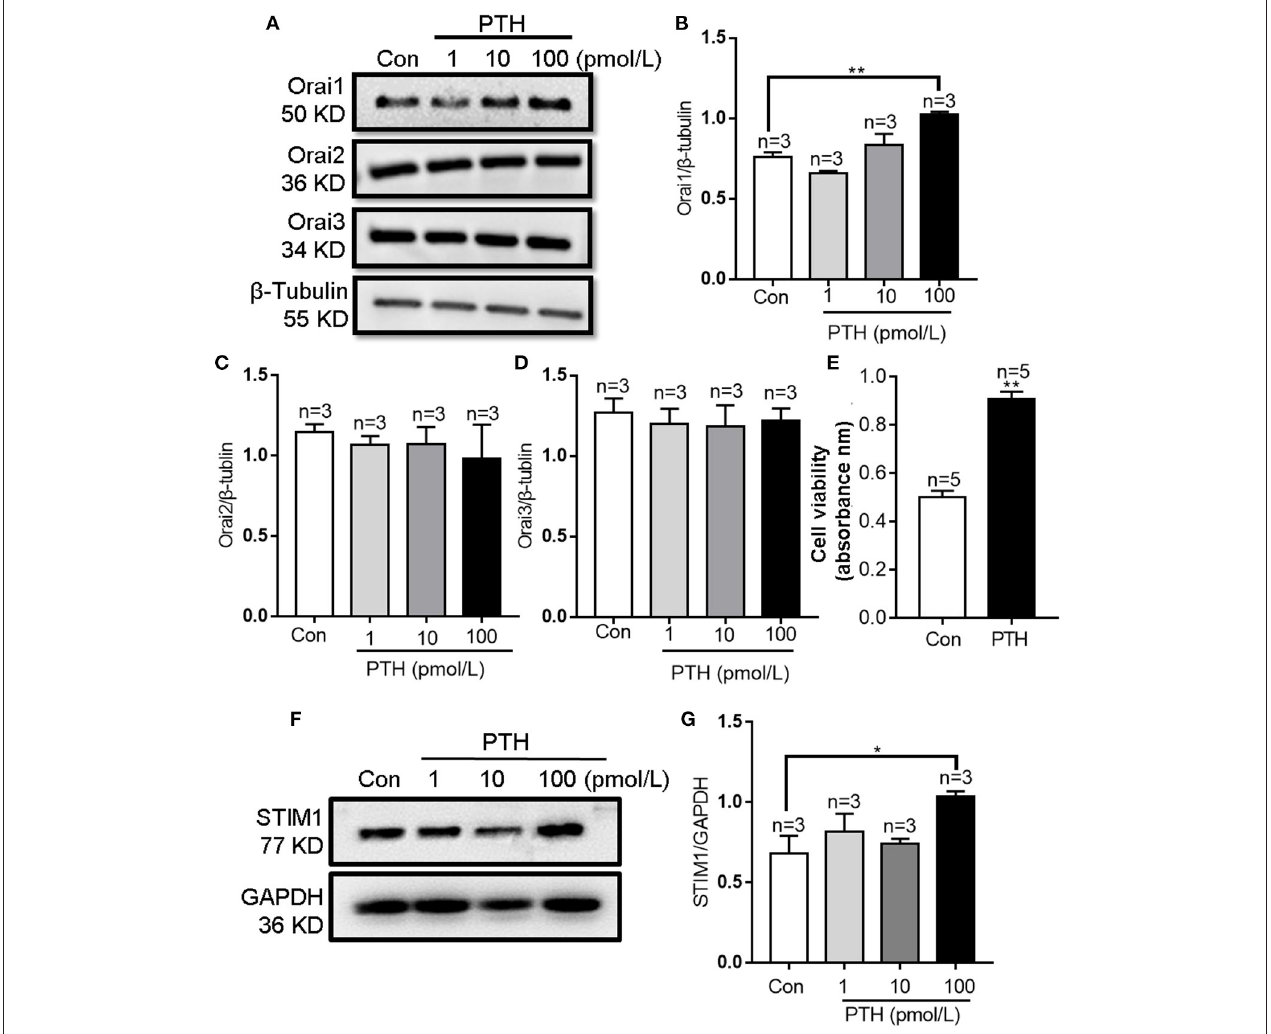
FIGURE 1 | Effects of parathyroid hormone (PTH) on Orai expression and proliferation of human umbilical vein endothelial cells (HUVECs). (A–D) Representative Western blot images (A) and summary data (B–D) showing Orai1, Orai2, and Orai3 expression level changes in HUVECs after PTH treatment (1, 10, 100 pM) for 24h compared with the vehicle control (Con). (E) Summary data showing viability of HUVECs treated with PTH (100 pM) for 24h. (F,G) Representative Western blot images (F) and summary data (G) showing STIM1 expression level changes in HUVECs after PTH treatment (1, 10, 100 pM) for 24h compared with the vehicle control (Con). Data are shown as the mean ± SEM; n = 3–5. * P < 0.05, ** P < 0.01 vs. Con analyzed by one-way analysis of variance followed by Dunnett’s multiple comparisons test.